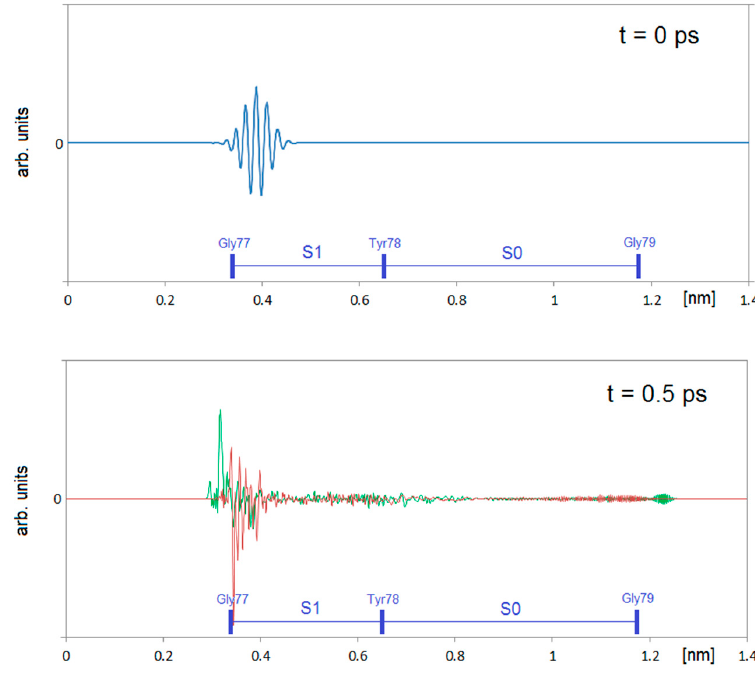
Figure 3. Top : Real part of the wave function at the beginning of the quantum mechanical Figure 3. Top: Real part of the wave function at the beginning of the quantum mechanical calculation. The length of one oscillation corresponds to the mean de Broglie wavelength given by